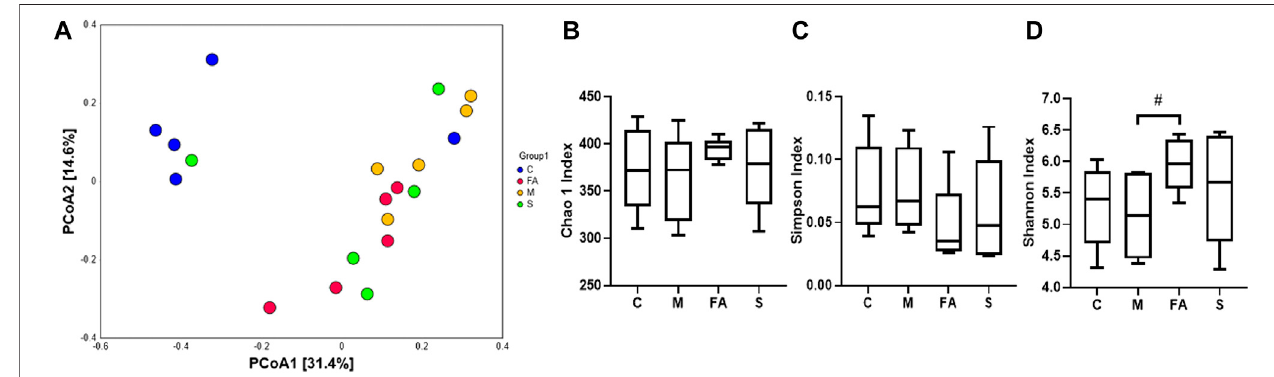
FIGURE 7 | The Effect of FA on gut microbiota composition in ApoE − / − mice (A) Relative abundances at phylum level. (B) Relative abundances of Firmicutes and Bacteroidetes ( n (cid:2) 5). (C) Relative abundances atfamily level. (D) Relativeabundancesof Erysipelotrichaceae and Ruminococcaceae ( n (cid:2) 5). (E) Relative abundancesat genuslevel. (F) Relativeabundancesof Ileibacterium and Lactobacillus ( n (cid:2) 5).* p < 0.05;ascomparedtothecontrolgroup.# p < 0.05;ascomparedtothemodelgroup.